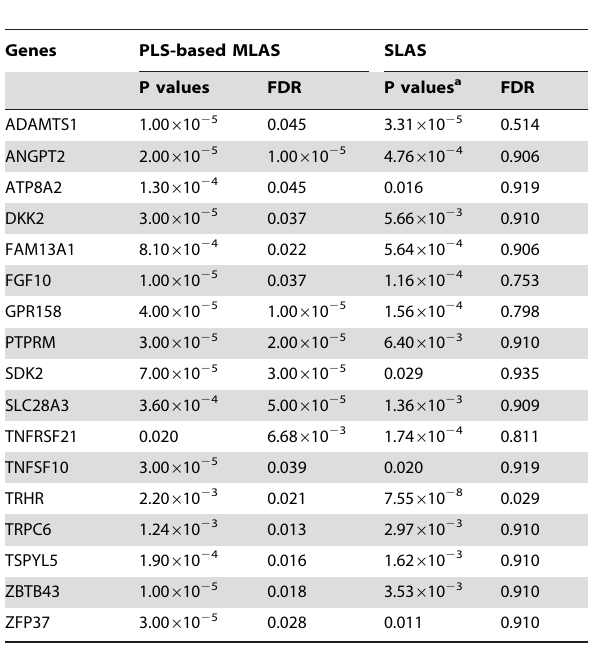
genes detected by PLS-based MLAS of lean body